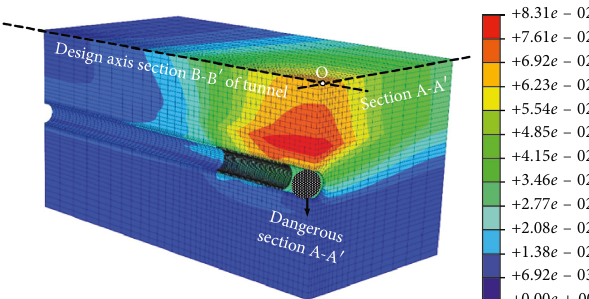
Figure 9: The local area of water inrush on the area excavation surface at the shield arrival stage.